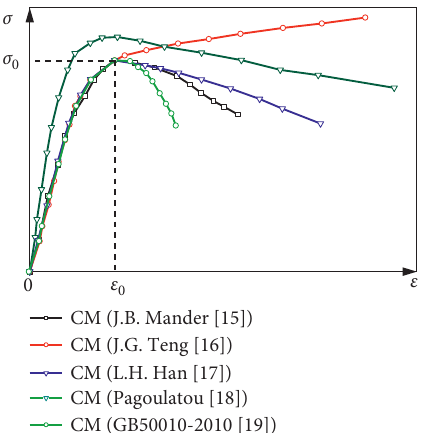
Figure 2: Typical constitutive models for